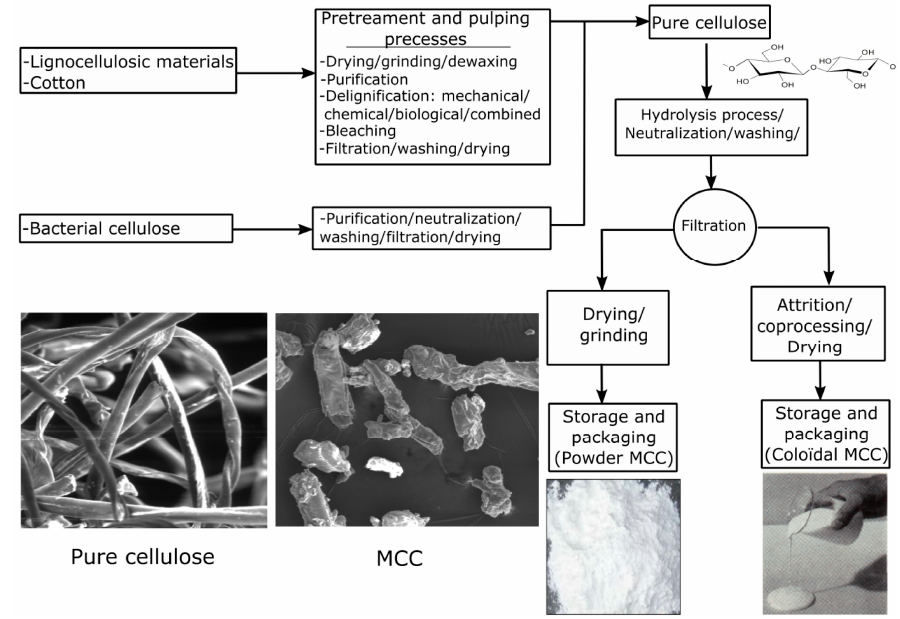
Figure 7. The manufacture process of microcrystalline cellulose, reproduced with permission from [77]; copyright Elsevier, 2016.